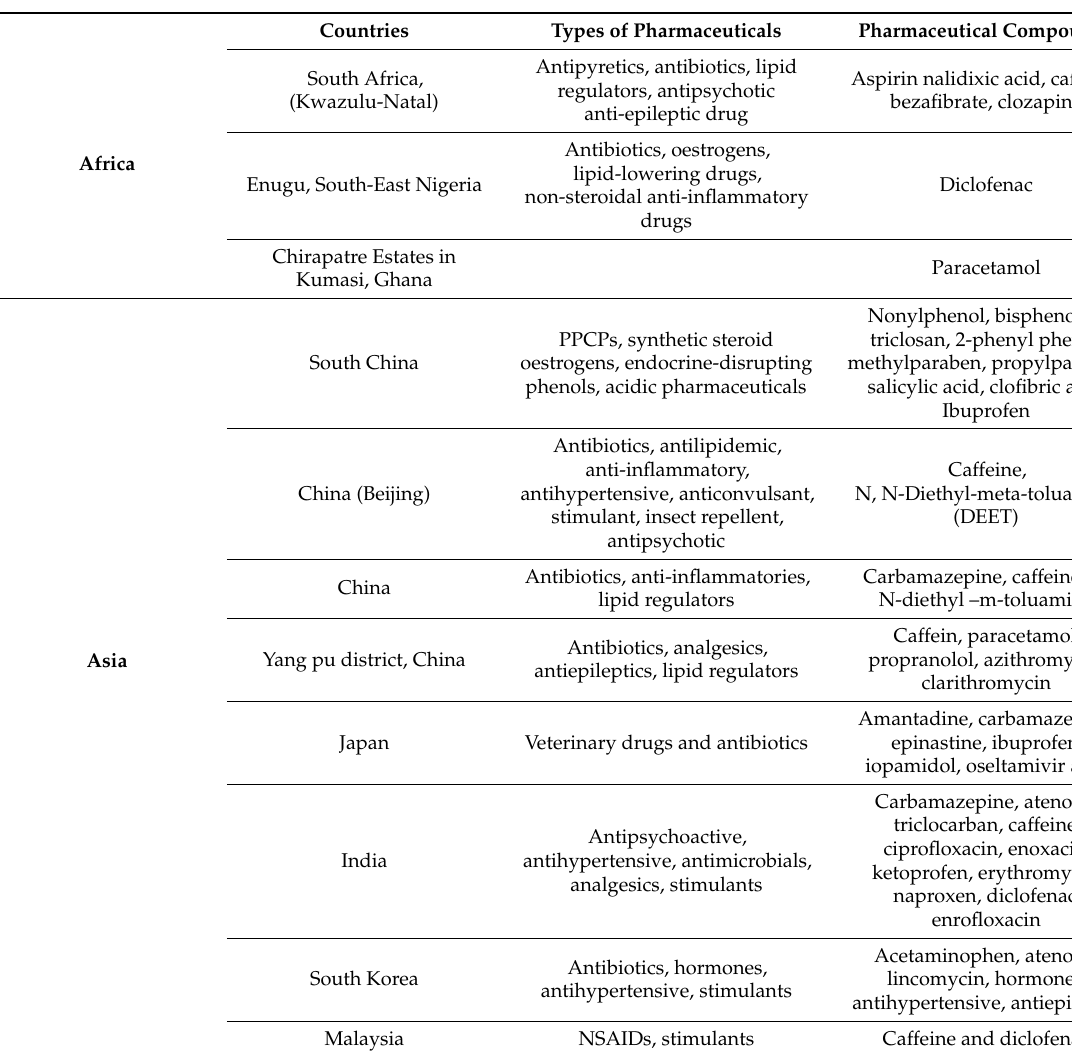
Table 1. Global occurrence of pharmaceutical compounds in water and